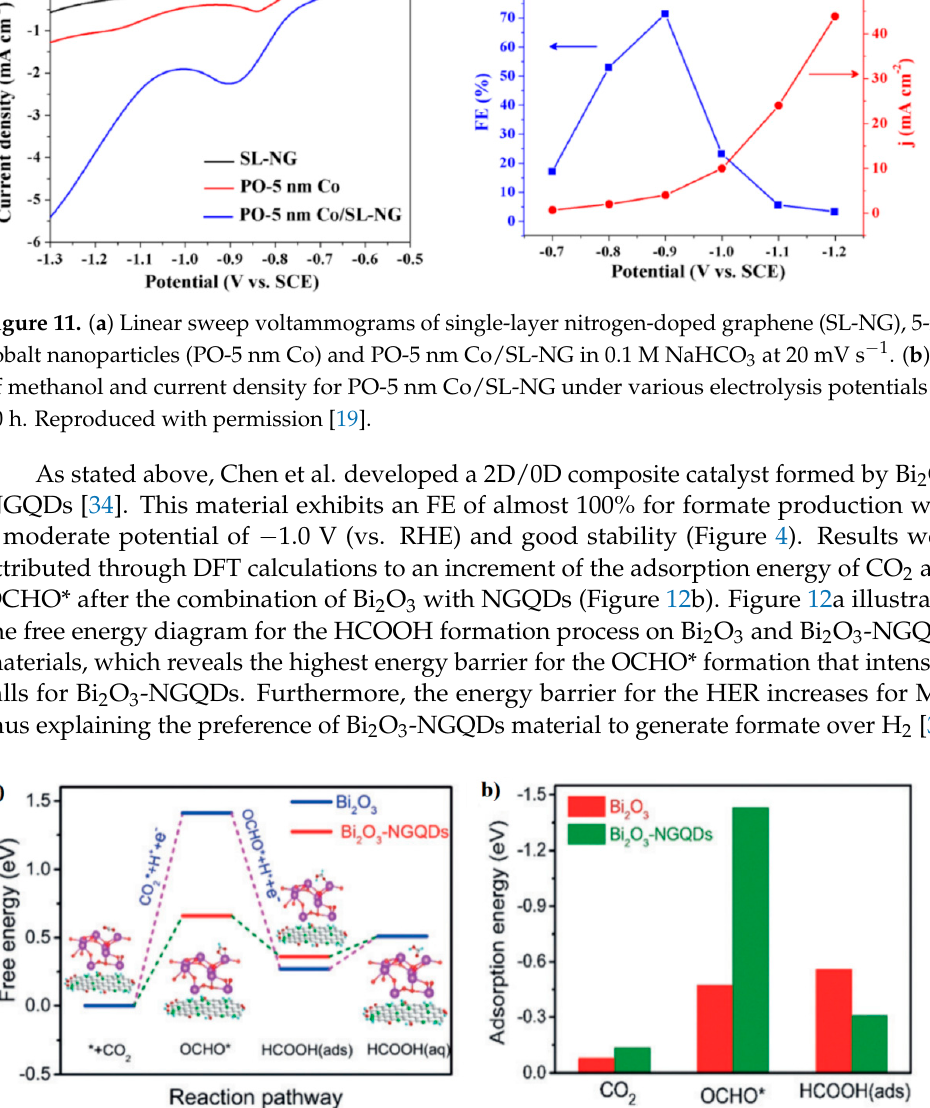
Figure 10. Left panel: Schematic Gibbs free energy profile for the H adsorption on different sur- faces. Right panel: schematic Gibbs free energy profile for the detailed CO 2 RR pathway on the surface (101) of three models. Reproduced with permission [34].